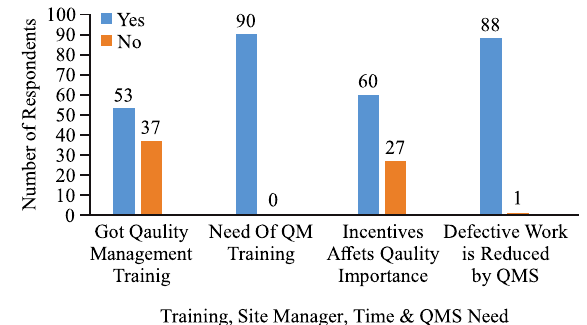
FIG. 5. IMPORTANCE OF QUALITY MANAGEMENT AND QUALITY MANAGER TRAINING & QMS INCENTIVES AND REDUCTION OF DEFECTIVE